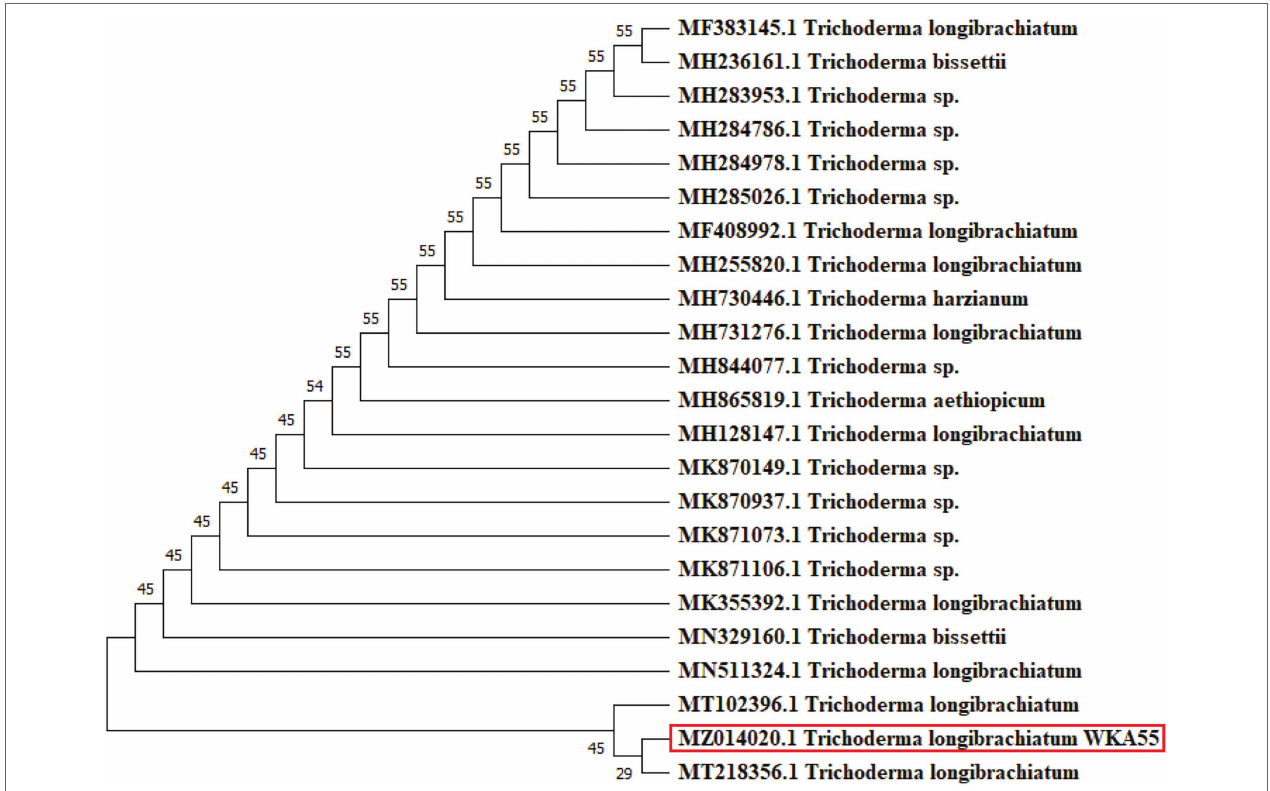
FIGURE 8 | Molecular phylogenetic tree of the sequence of 18s rRNA, showing the position of Trichoderma sp. strain WKA55 (surrounded with the red rectangle) within the closely related sequences in